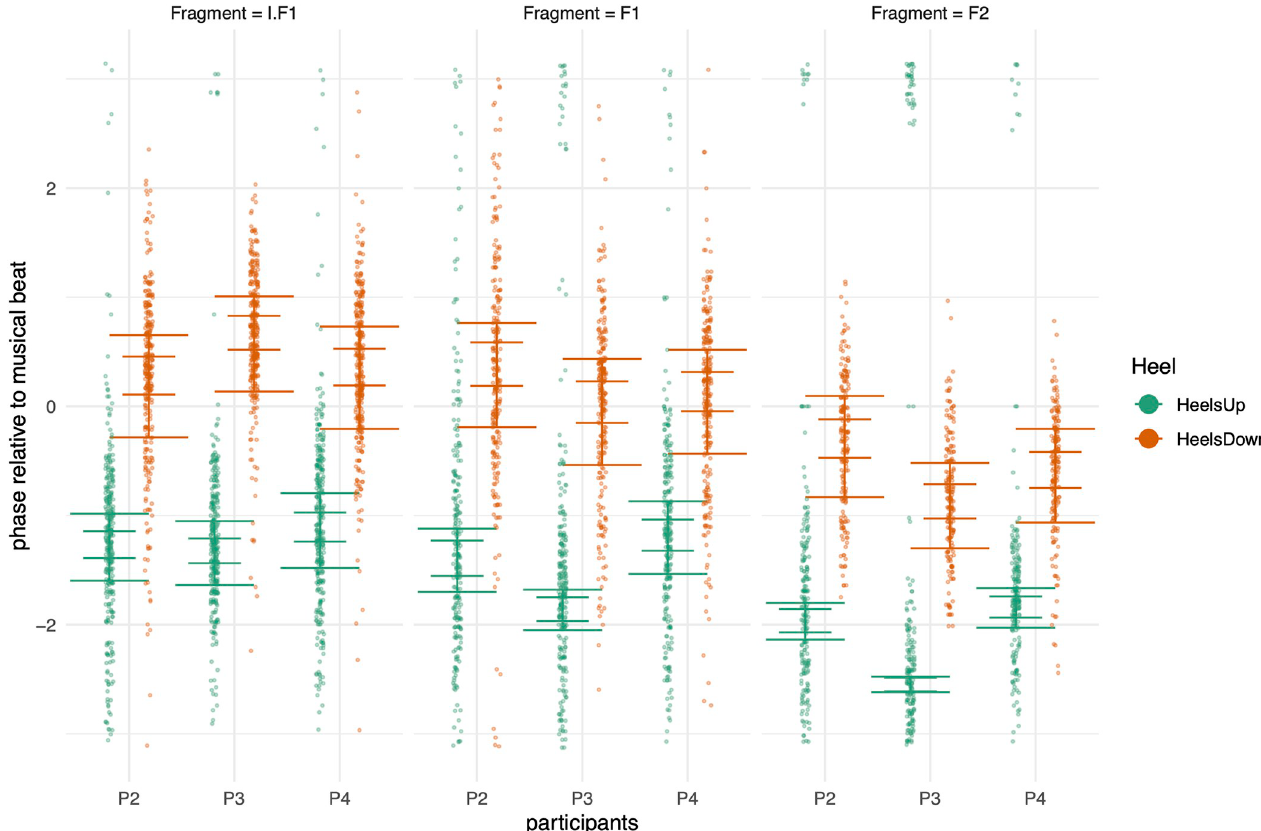
Fig 5. Results of model H1H3. Short horizontal error bars indicate the CI with 95% probability mass in favor of the expected value of the posterior predictive distribution, excluding the group-level effect of Trial. The long horizon error bars include the group-level effect of Trial.